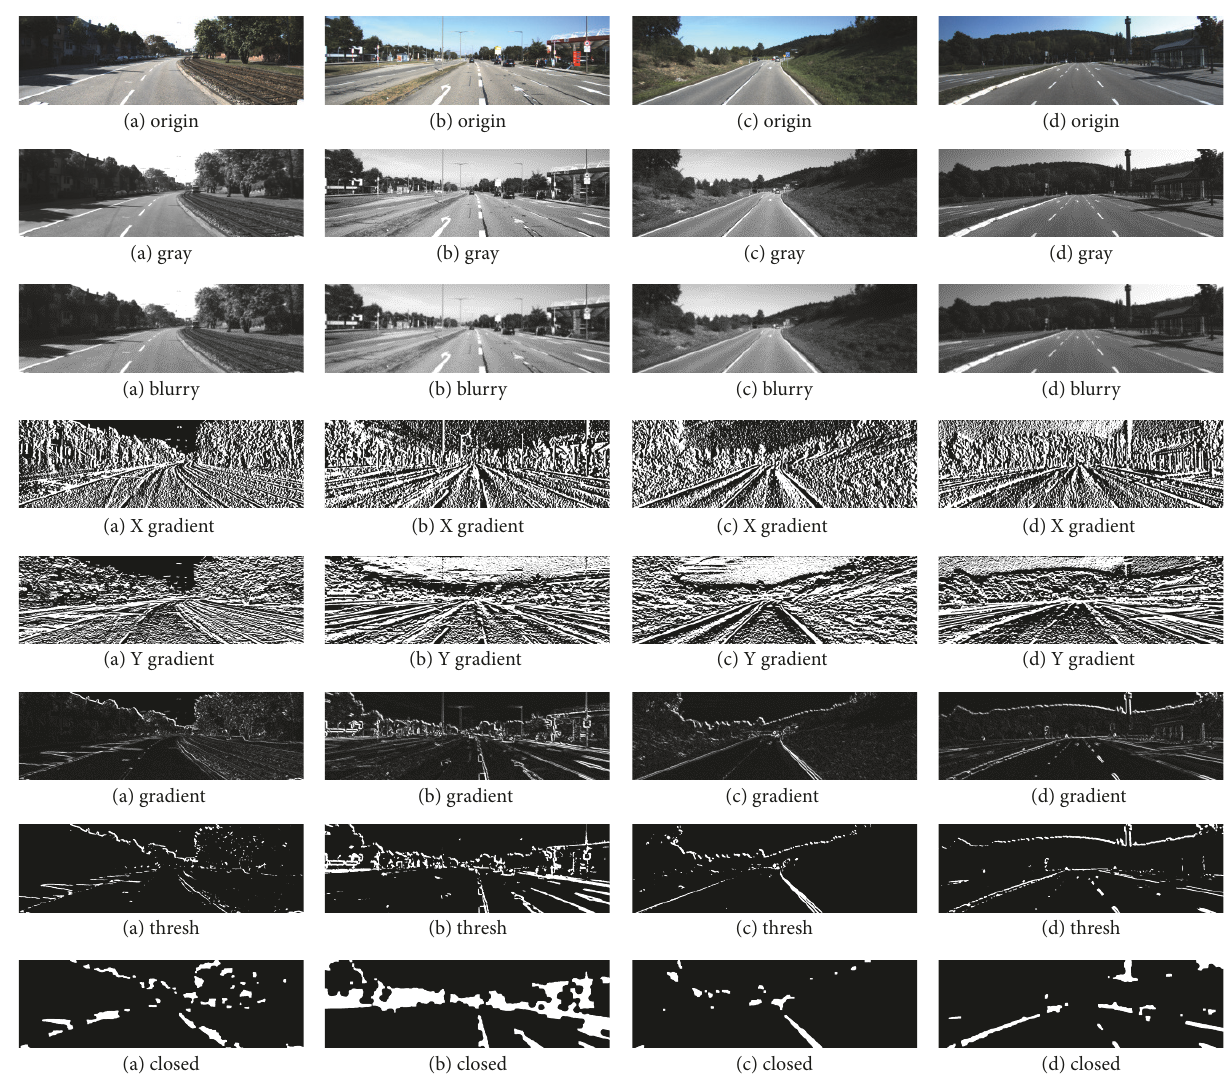
Figure 7: Basic preprocessing of sample frames (a), (b), (c), and